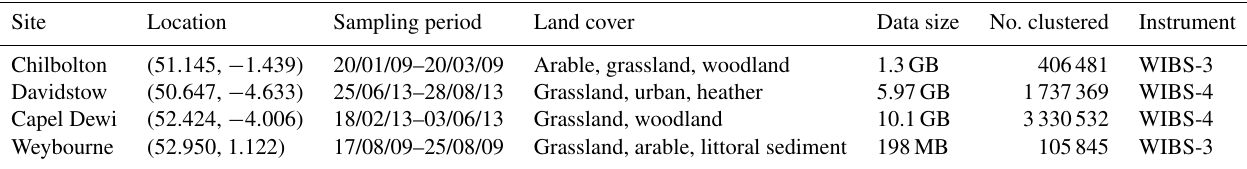
Table 1. The site name, geographic location (latitude, longitude), sampling period of each campaign, examples of land cover at each site, size of the data, number of particles clustered at each site, and the instrument used for the campaign